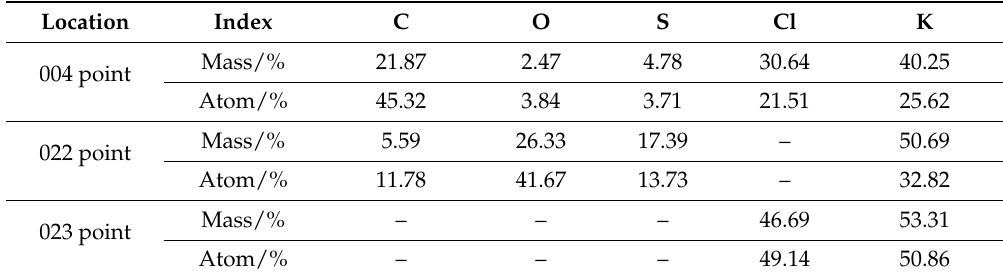
Table 6. The energy disperse spectroscopy (EDS) analysis results of different crystals on aggregate surface.